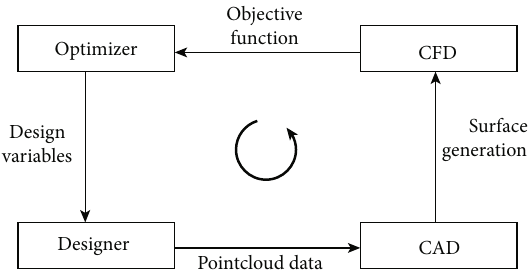
Figure 6: The speci fi c optimization process.